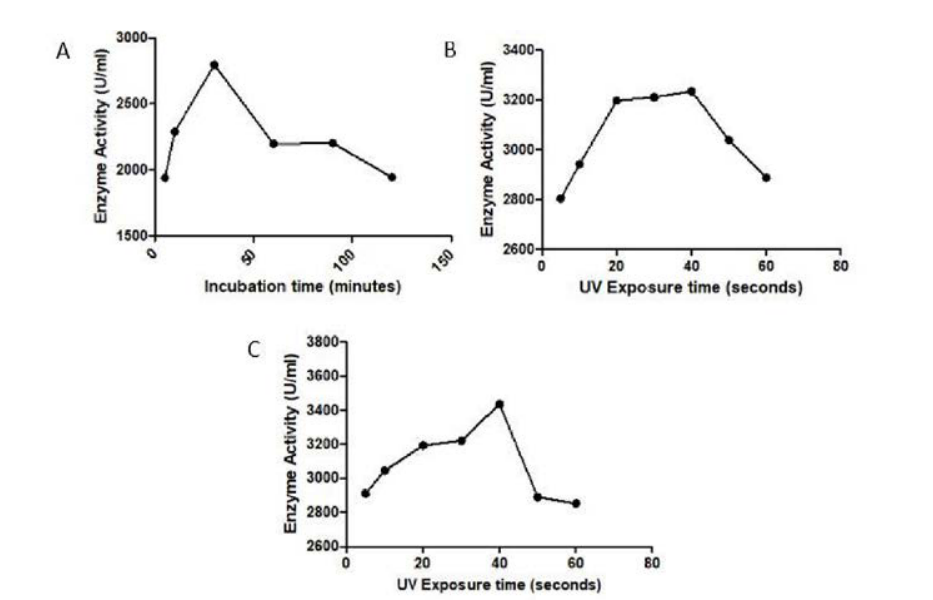
Fig. 2. Effect of random mutagenesis on serrapeptase activity: A) UV Mutagenesis, B) Chemical Mutagenesis, C) Combination of UV+EMS